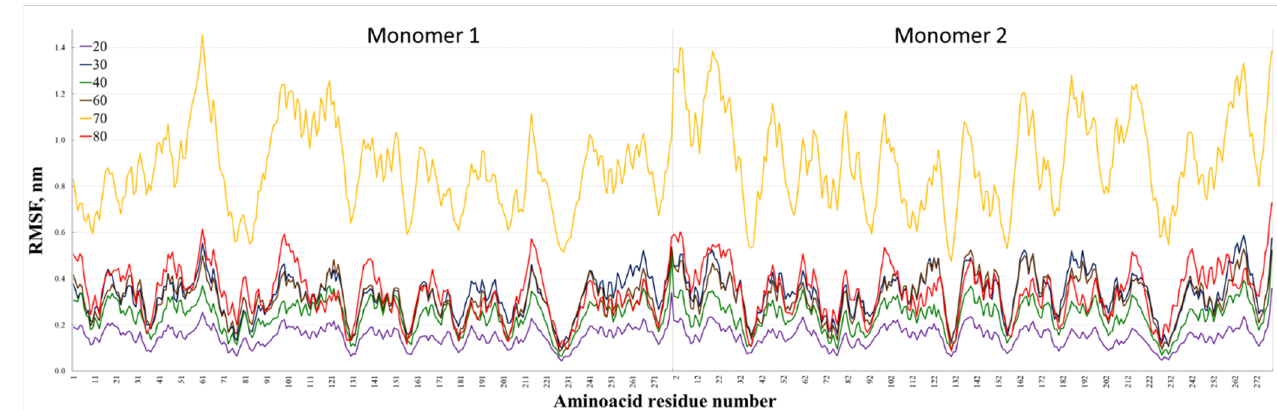
Figure 1. RMSF graphs of C α atoms of proteinase K dimers simulated in a solution at several temperatures (20, 30, 40, 60, 70, and 80 °C).